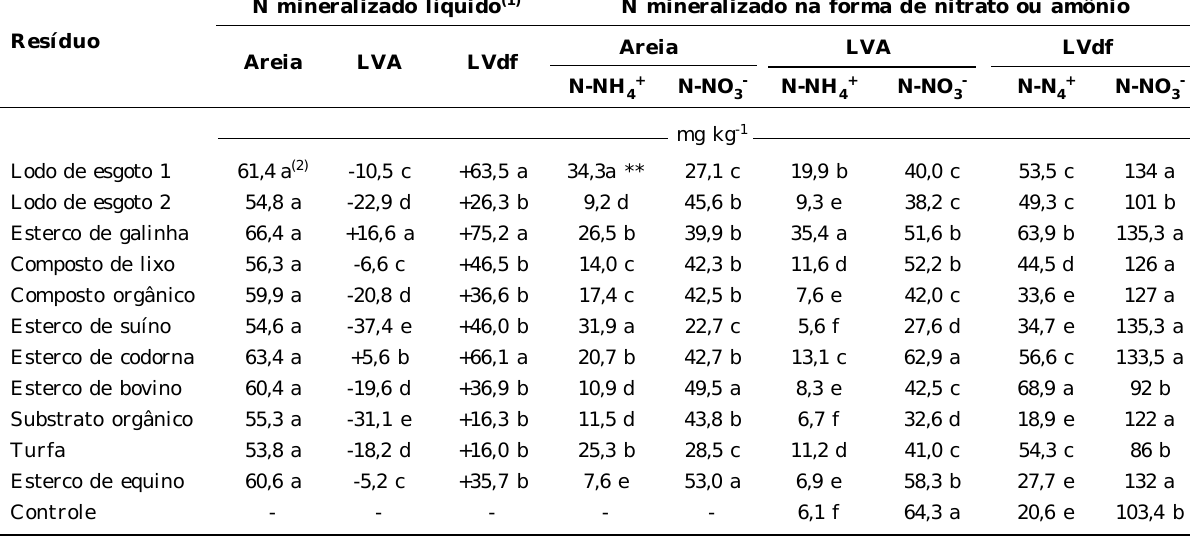
tempos de meia-vida de N na faixa de 43 a 154 dias. Em relação às formas de N mineralizado disponibilizadas nos solos e na areia, predominou o N-nitrato, em relação o N-amônio; contudo, as proporções de N-nítrico/N-amoniacal variaram conforme a mistura solo-resíduo analisada (Quadro 3). No LVdf, as condições favoráveis à mineralização de N também resultaram em maior nitrificação, com teores de N-nitrato, após 270 dias de incubação, variando de 86 a 135,3 mg kg -1 ; no LVdf, o N-nitrato representou de 2 (lodo de esgoto 2) a 6,6 (substrato orgânico) vezes os teores de N-amônio determinado ao término da incubação. Na areia, à exceção do lodo de esgoto 1 e do esterco de suíno e para os resíduos incubados no LVA, o nitrato predominou em relação ao amônio, mas, proporcionalmente, a disponibilidade de N-nítrico em relação ao amoniacal é menor nesses dois meios, em relação à verificada para os resíduos incubados no LVdf. No trabalho de Boeira & Maximiliano (2009), a maioria do amônio produzido durante a decomposição de lodos em solo foi convertida em nitrato, de modo que foi verificado aumento linear de N-nítrico ao longo da incubação; seus teores se evidenciaram dependentes da dose de lodo aplicada. O efeito da composição química dos resíduos orgânicos sobre a mineralização ficou evidenciado quando se avaliou o grau de associação entre as